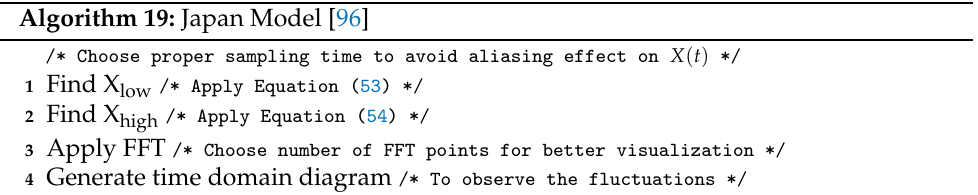
Algorithm 19: Japan Model